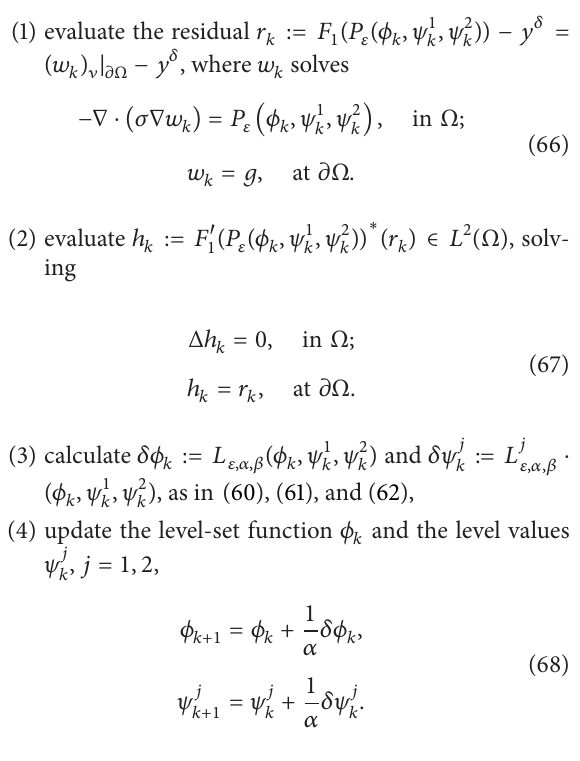
Algorithm 20 (iterative algorithm based on the level-set approach for the inverse potential problem). Given 𝜎 and 𝑔